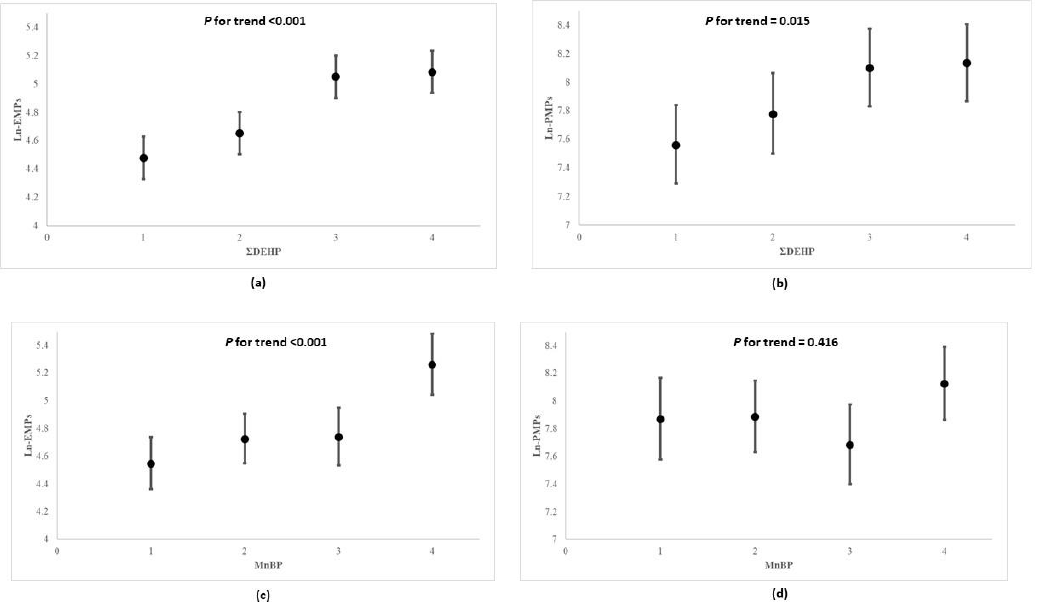
Figure 2. Geometric mean values and 95% confidence intervals of natural log-transformed EMPs and PMPs according to quartile concentrations of urinary Σ DEHP and MnBP a in multiple linear regression model b . ( a ) Σ DEHP and Ln-EMPs, ( b ) Σ DEHP and Ln-PMPs, ( c ) MnBP and Ln-EMPs, ( d ) MnBP and Ln-PMPs. DEHP: di-2-ethylhexyl phthalate; MnBP: mono-n-butyl phthalate; EMP: endothelial microparticles; PMP: platelet microparticles. a Σ DEHP as µ mol/g creatinine, and others as μg/g creatinine. EMPs and PMPs as counts/μL. b p for trend analysis—value was modeled according to median value of each quartile of each phthalates metabolites, and was adjusted for age, gender, body mass index, total cholesterol, hypertension, diabetes, smoking, alcohol consumption, physical activity, and household income. Table 4. Multiplicative factors (95% confidence intervals) for a change in serum endothelial and platelet microparticle level a associated with an interquartile range change in urinary phthalate metabolites level b in multiple linear regression model c .